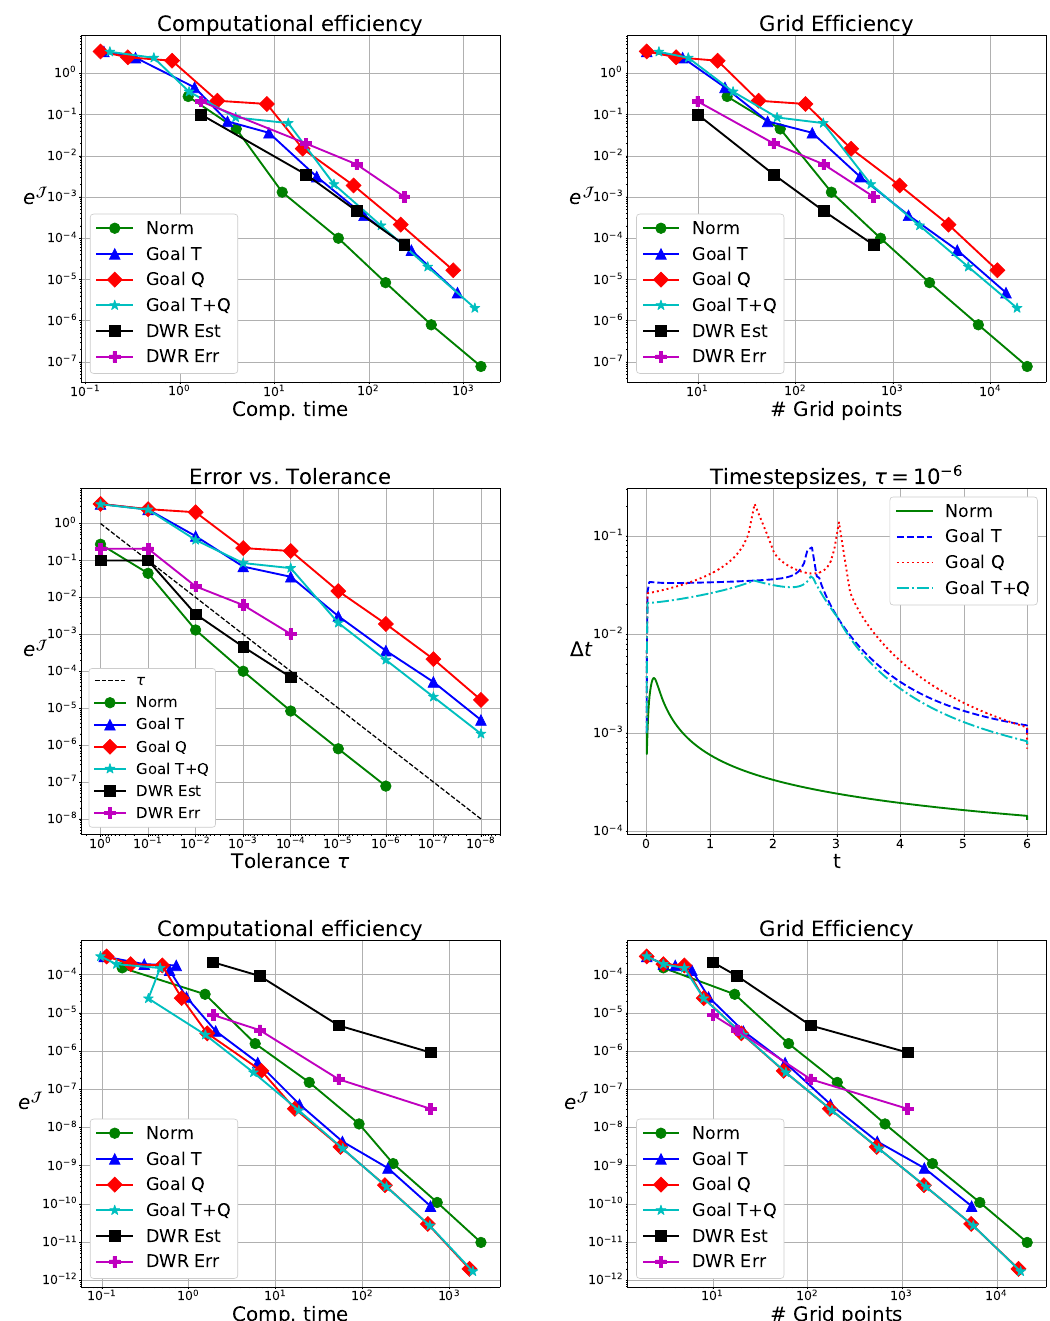
Figure 4. Comparison of the various methods for the convection diffusion Problem (34) with QoI as in Equation (35). ( Top ): Performance for positive v . ( Centre ): Tolerance over error and chosen timesteps for τ = 10 − 6 (positive v ). ( Bottom ): Performance for negative v and t e =